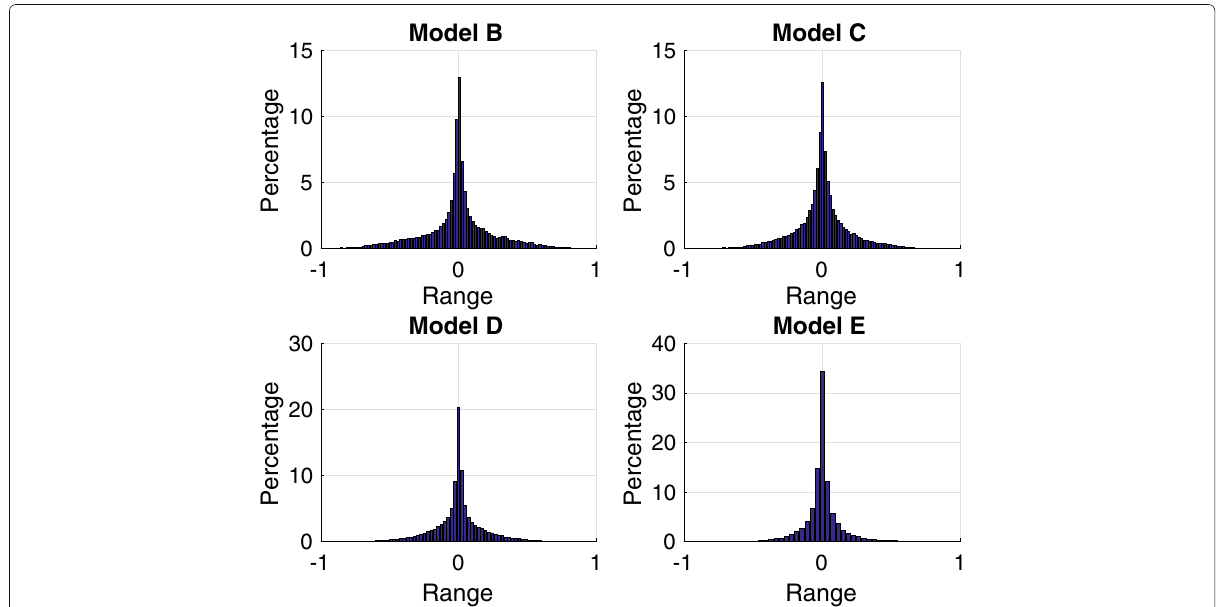
Fig. 12 Coefficient values with model data. The distribution of the fit coefficients found by CSIApx for the strongest antenna pair when evaluated on the synthesized CSI data